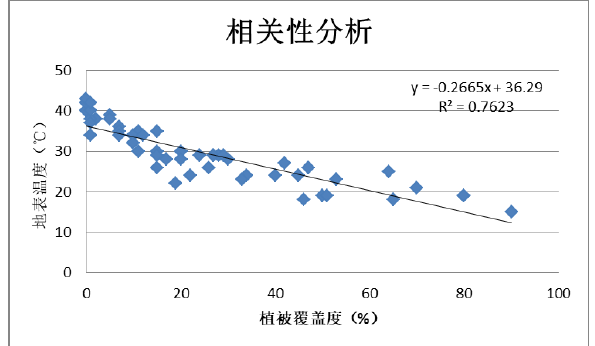
Figure 7.The analysis of heat island and vegetation